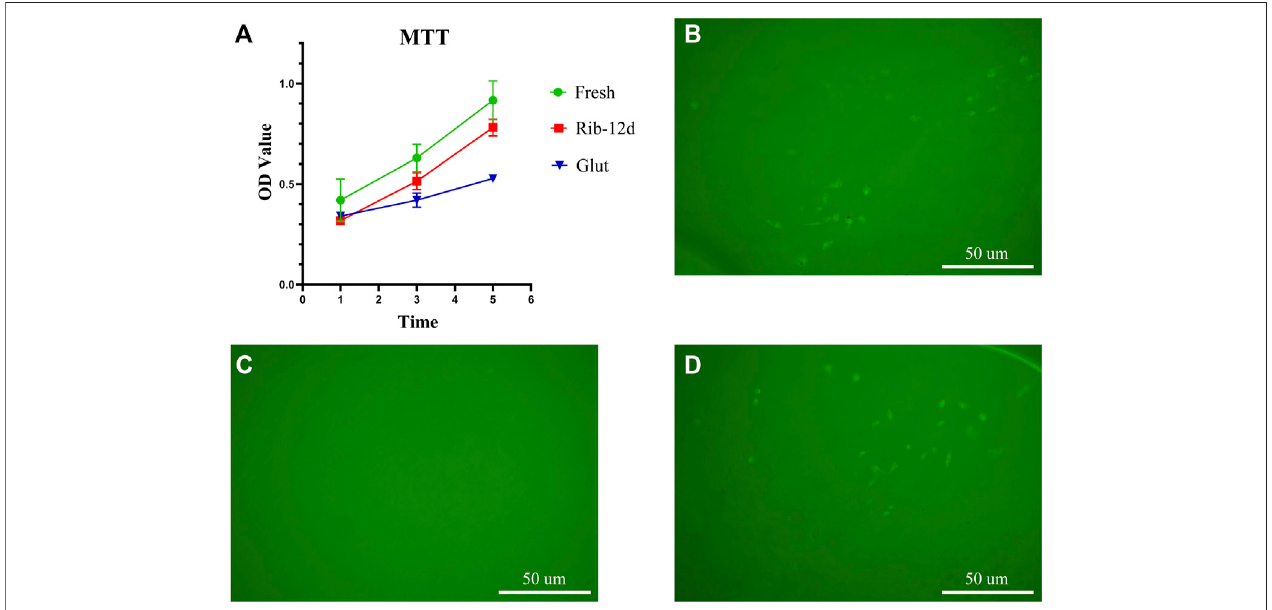
FIGURE 9 | Cytocompatibility of the biomaterial. (A) Cell viability was tested by MTT assay at 1, 3, and 5 days ( n = 3). (B – D) HUVEC growth on fresh BP, Glut- treated BP, and Rib-treated BP after 7 days of culture. Scale bars: 50 μ m.